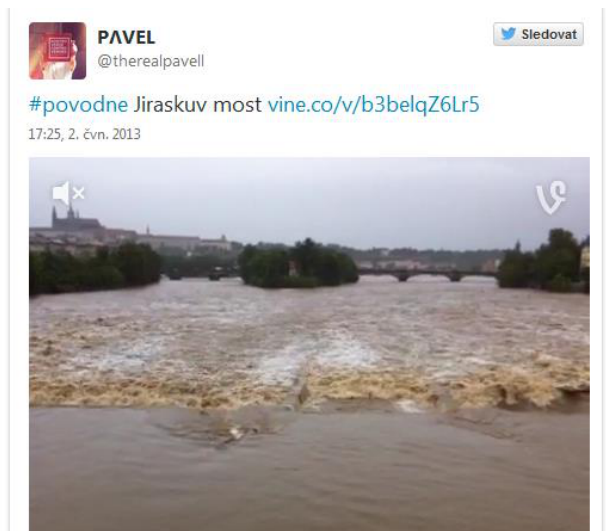
Figure 2. Twitter as a popular source of crisis